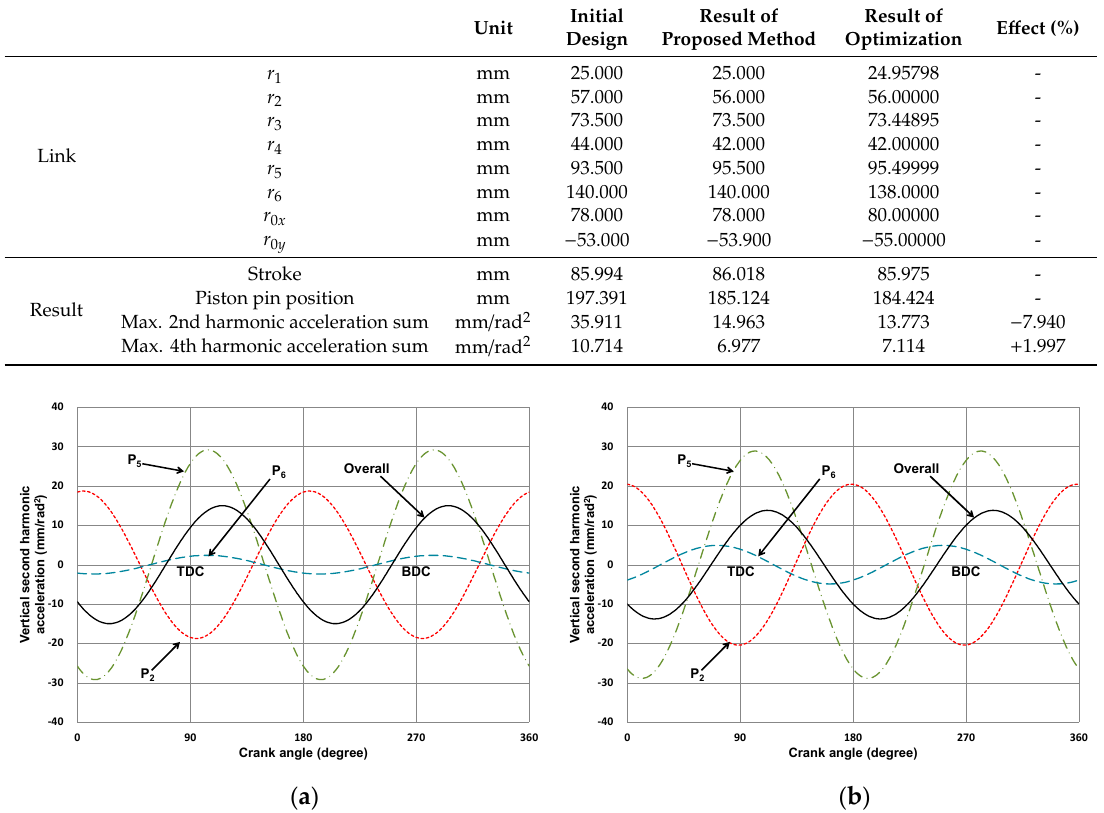
Figure 13. Vertical second harmonic acceleration components at joints of the Stephenson III mechanism in the four-cylinder engine: ( a ) proposed method and ( b ) optimization using commercial software.